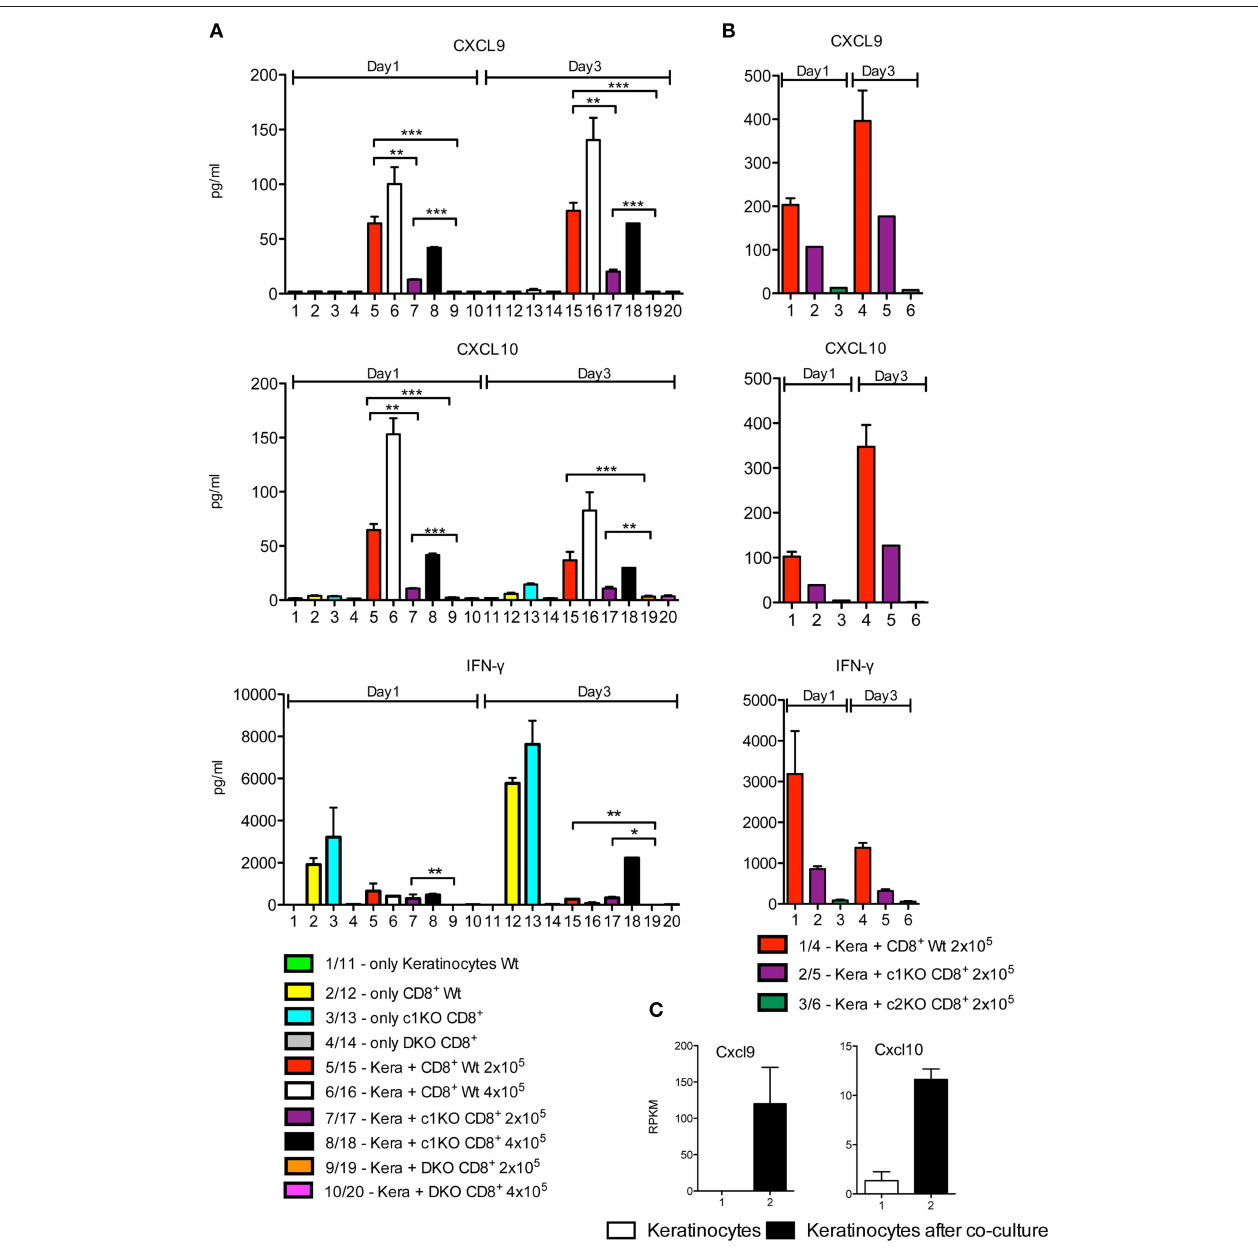
FIGURE 4 | Induction of CXCL9, CXCL10 and IFN- γ secretion in keratinocytes upon co-culture with CD8 + T cells. (A,B) Secretion of chemokines CXCL9 and CXCL10 and of IFN- γ by keratinocytes and CD8 + T cells. Keratinocytes cultured for 7 d in vitro and splenic CD8 + T cells pre-activated by α CD3/CD28 Ab for 1 d were either cultured alone or together in 6-well plates for another 1 or 3 d as indicated and their chemokine and IFN- γ secretion measured. In (A) the incubation of NFAT-DKO T cells was included, in (B) the incubation of NFATc2-ko instead of DKO T cells. (C) Induction of Cxcl9 and Cxcl10 transcription in keratinocytes that were cultured alone (column 1) or together with the same number of pre-activated CD8 + T cells for 1 d (column 2). In the co-culture, the CD8 + T cells were washed off, and the RNA levels of keratinocytes were determined in NGS assays, * p < 0.05, ** p < 0.005, *** p < 0.001.